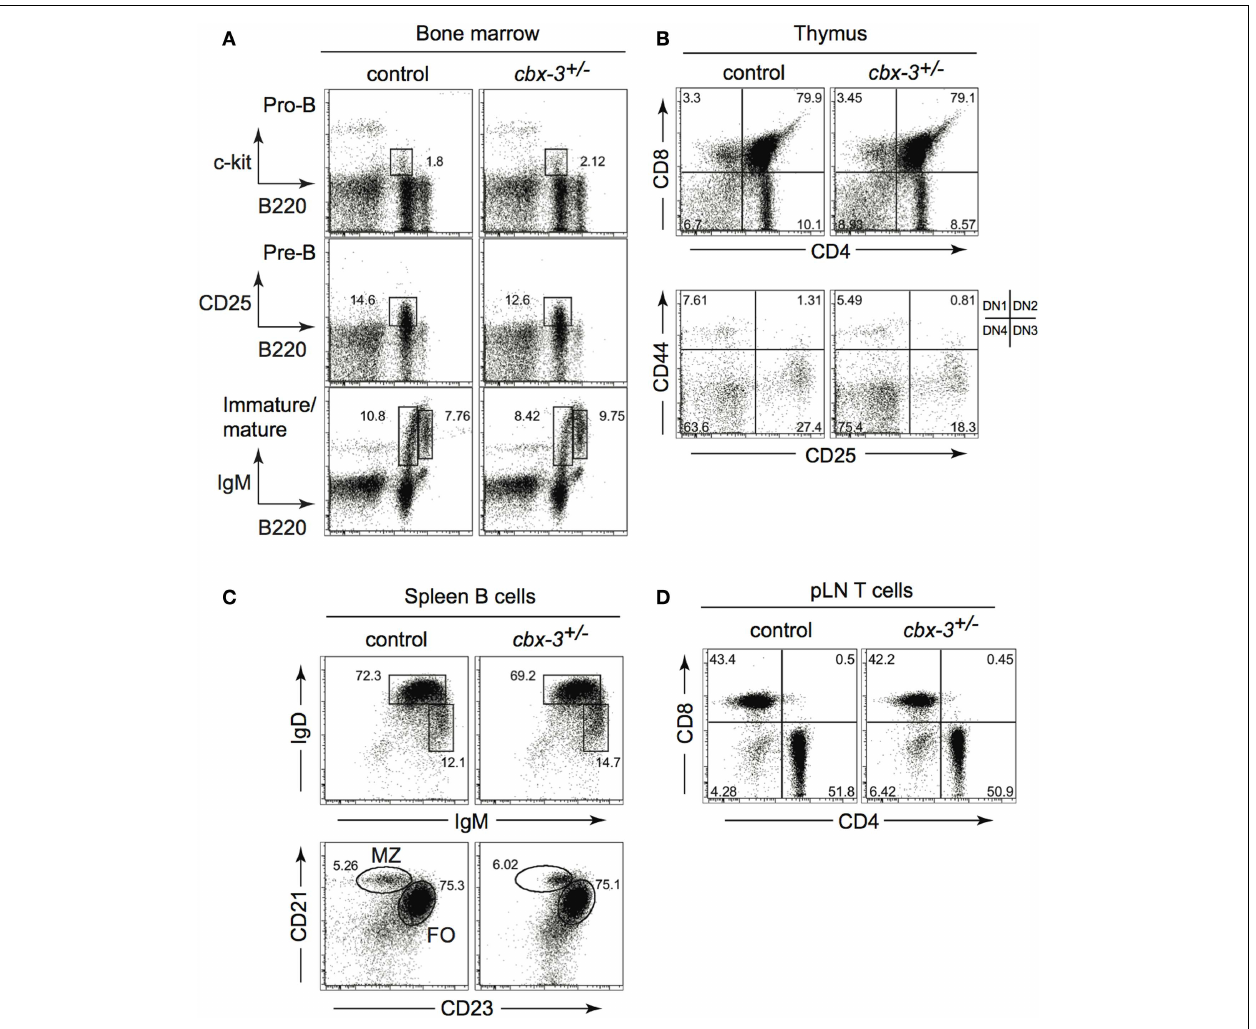
plots were gated on the CD4 − CD8 − population. (C) All plots were gated on CD19 + lymphoid population. Frequency of mature (IgD hi IgM lo ), marginal zone (CD21 hi CD23 lo ), and follicular (CD21 lo CD23 hi ) spleen B cells was determined by FACS. (D) Lymphoid cells from peripheral lymph nodes (pLNs) were gated on the CD3 + population, and analyzed to assess the development of mature CD4 + and CD8 + T cells. Results are representative of three independent experiments with n = 6 of each